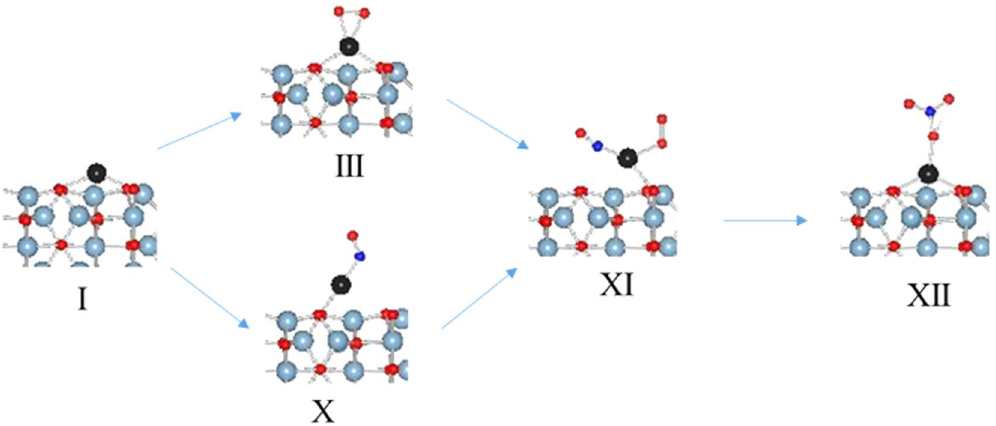
Figure 8. NO interaction with single supported Pd atom.